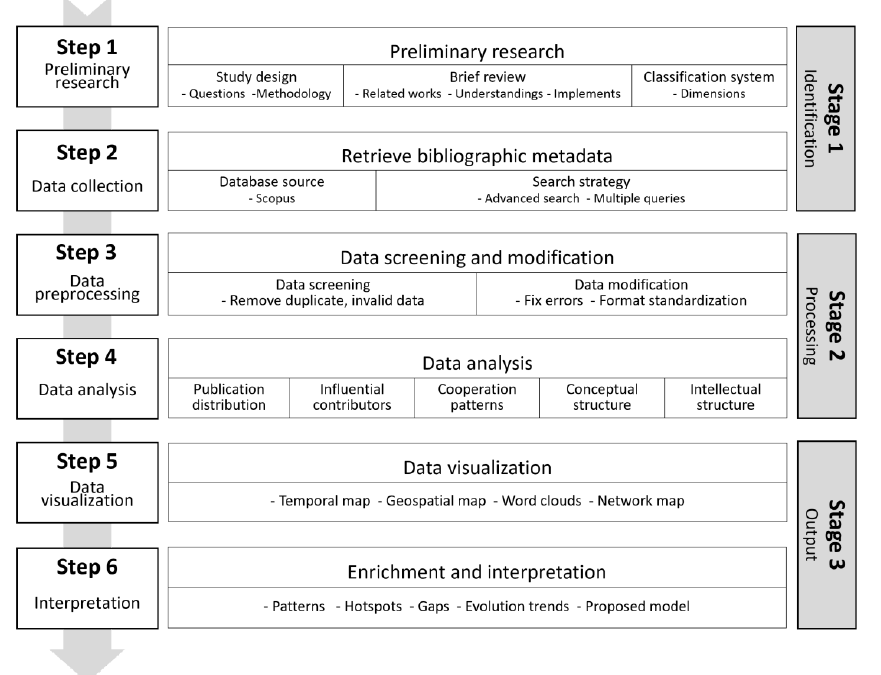
Figure 1. Workflow of the